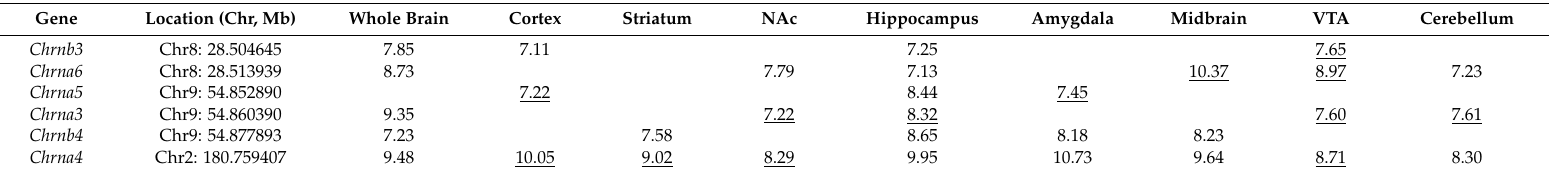
Table 3. Chrn gene expression at whole brain and different brain areas of BXD